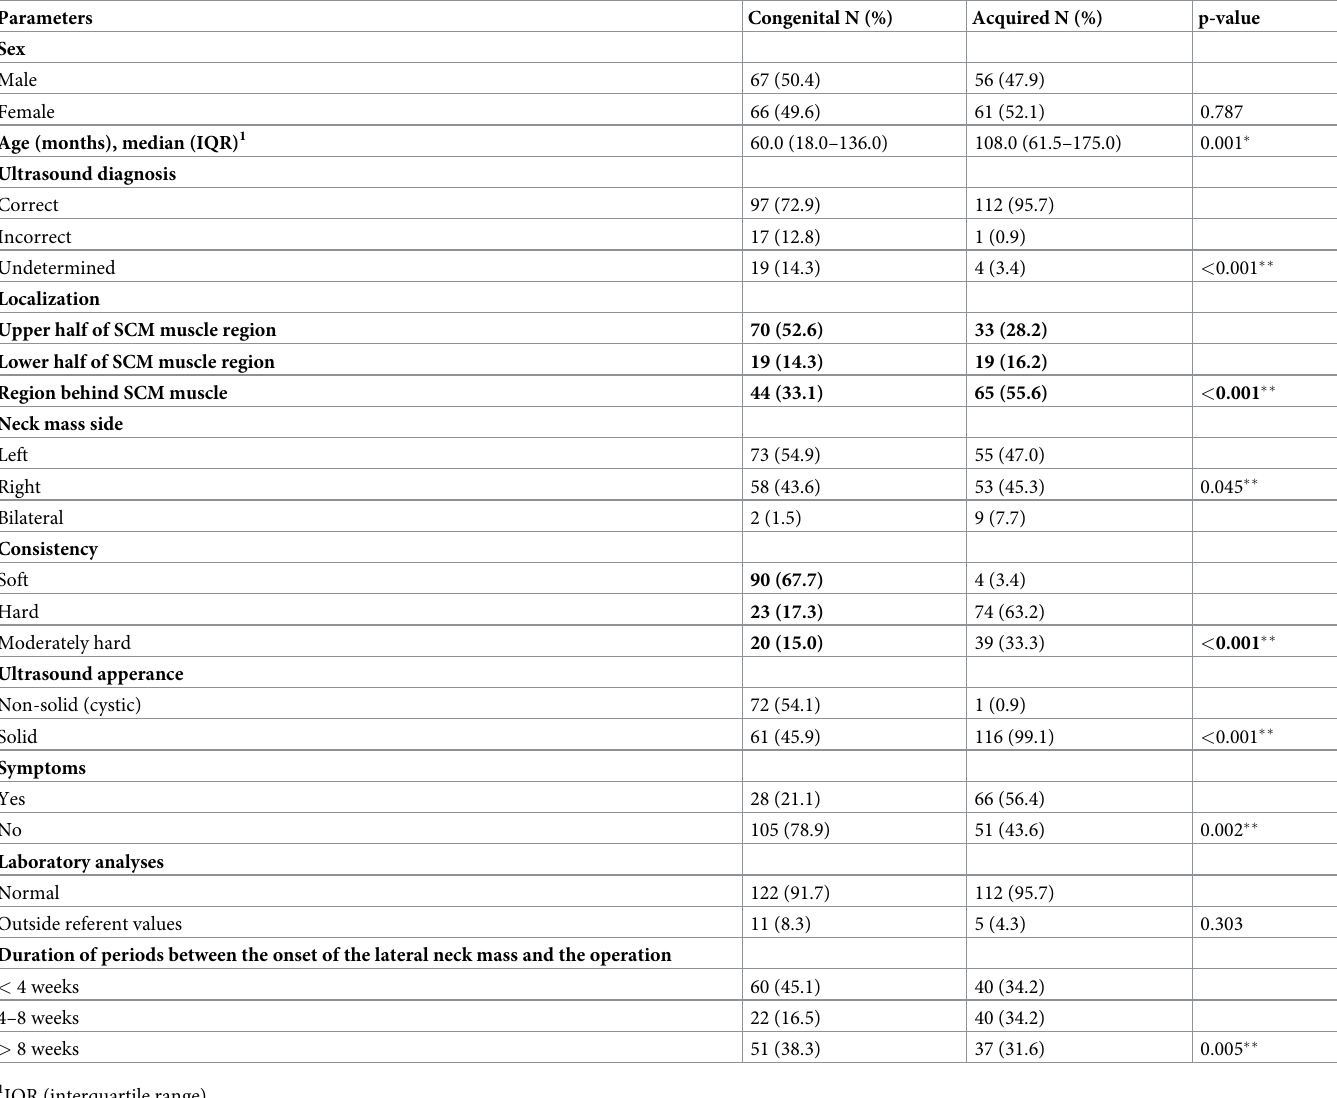
Table 1. The demographic, clinical, and ultrasound characteristics of pediatric patients with congenital and acquired lateral neck